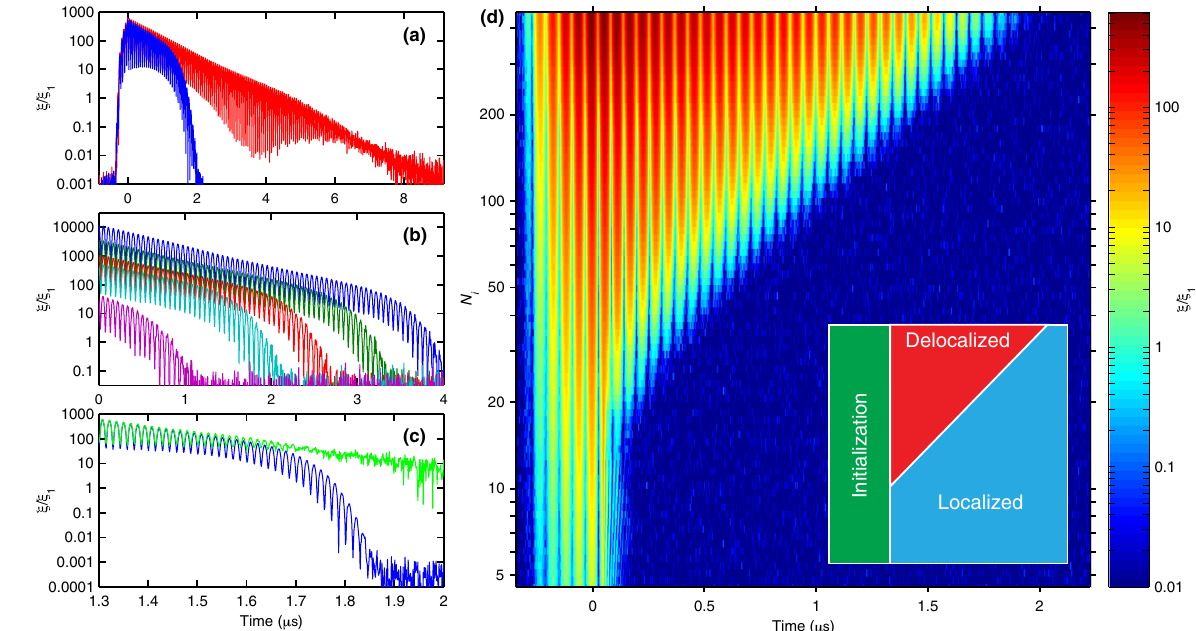
FIG. 6. Dissipation-driven transition and phase diagram. (a) Comparison of homodyne signal when photon-photon interactions are off > N (red) and on (blue), with N . The same initialization pulse V was used as in Fig. 5. With interactions off, the system undergoes i c drive oscillations and exponential decay at rate κ , which can be observed for several microseconds. Significantly, the presence of interactions causes superexponential decay of the homodyne signal as N approaches N , a signature of crossover into the localized regime. (b) The c time of onset of superexponential decay t shifts with initial photon number, as shown here for initialization pulses with varying drive c power lasting 11 . 5 μ s ( 100 =J ). The use of a long initialization pulse makes it possible to drive the system to very large initial photon ≈ 12 000 , 3800, 1100, 550, 40), but introduces complications (see Supplemental Material for more details numbers (top to bottom: N i [45]). (c) Directly measuring the photon number (green) reveals that incoherent photons remain in the system after the homodyne signal (blue) has undergone superexponential decay. Oscillations in the photon number can also be observed to die out, as critical slowing- down constrains the envelope of oscillations, finally leaving only exponential decay. Here, V is 1 . 15 μ s ( 10 =J ) and τ ¼ 1 μ s. drive Background voltages leading to distortion of the signal were removed from the photon number measurement. (d) Reconstructing the phase diagram by monitoring the homodyne signal as a function of initial photon number and time. At high powers, the dynamical transition from linear oscillations to localized behavior is marked by superexponential decay, while at low powers the collapse and revival signatures of localized behavior are observed. A 345 ns ( 3 =J ), an initialization pulse V ending at t ¼ 0 is used with drive τ ¼ 65 ns, corresponding to an initial imbalance Z ≈ − 0 . 6 . Inset: Illustration of the phase diagram showing the different dynmical